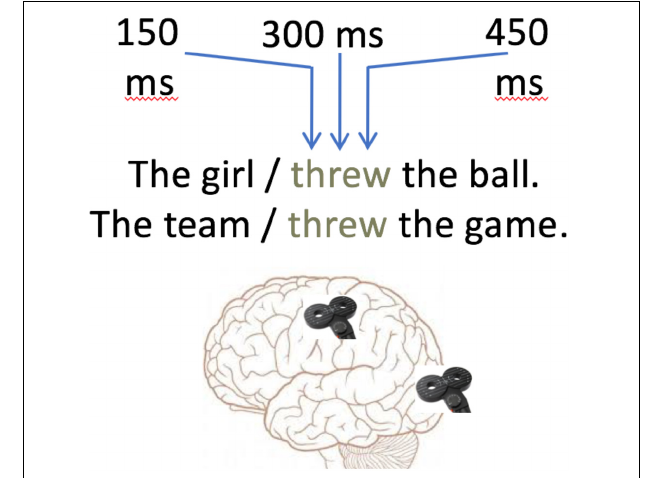
FIGURE 1 | Example trial sentences and stimulation